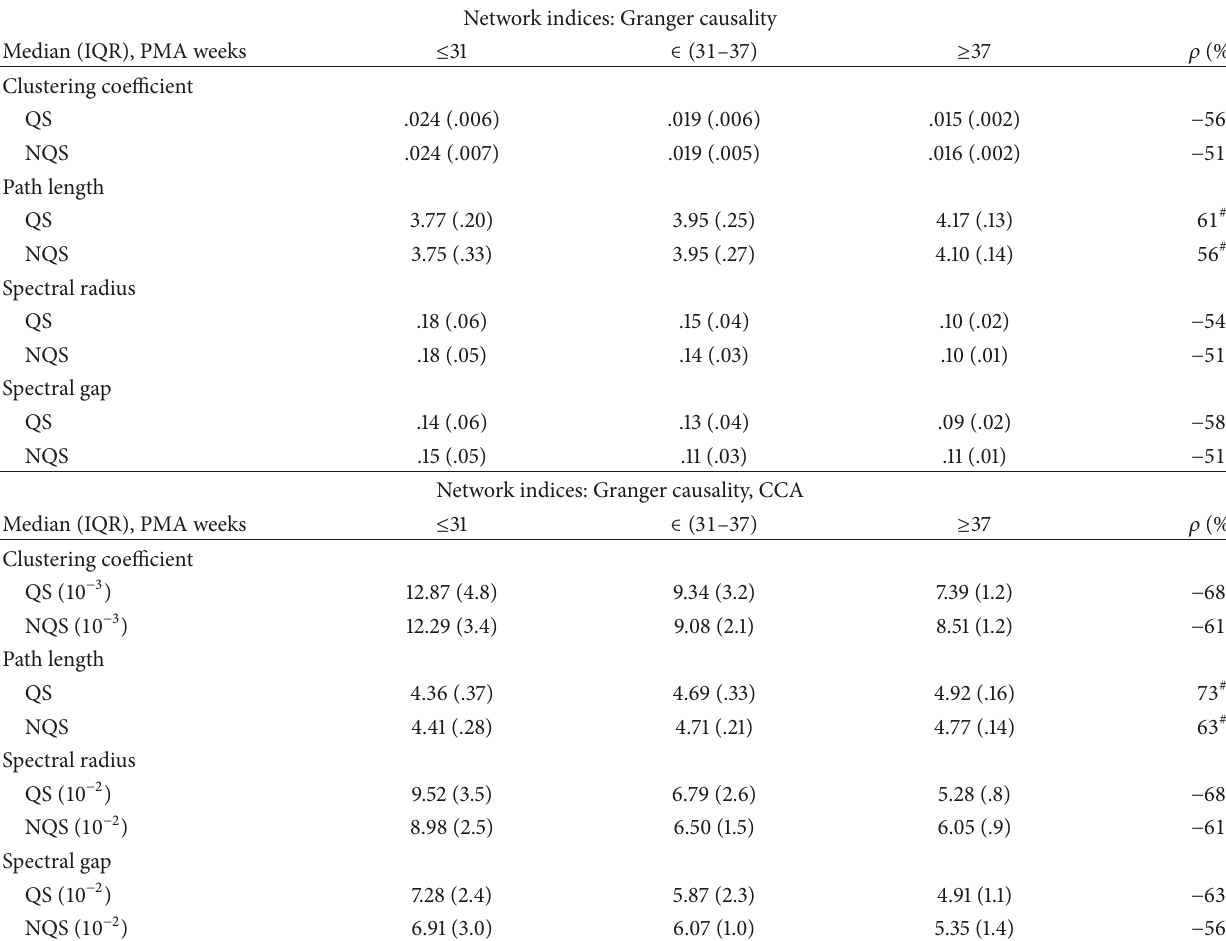
Table 3: The main integration and spectral features in three discrete time points. The table shows the indices for both sleep states (QS = quiet sleep, NQS = nonquiet sleep) and they were computed on the Granger causality connectivity graph. The results are reported as median (IQR), where IQR stands for InterQuartile Range . The symbol 𝜌 stands for the Pearson correlation coefficient, while # represents a significant correlation with 𝑝 ≤ 0.01 . The values 10 −3 or 10 −2 mean the reported results are multiplied by a factor 10 −3 or 10 −2 .